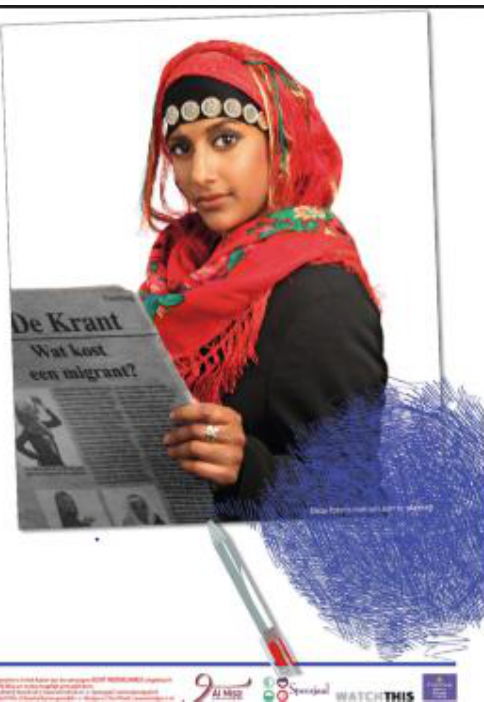
Figure A2. “Real Dutch?” Poster Campaign by Al Nisa .